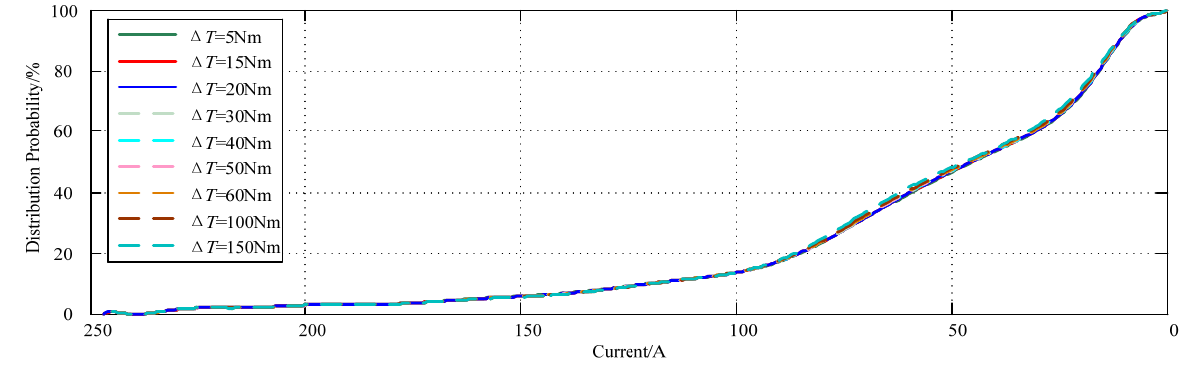
Figure 10. The distribution probability of the absolute value of the battery T  .